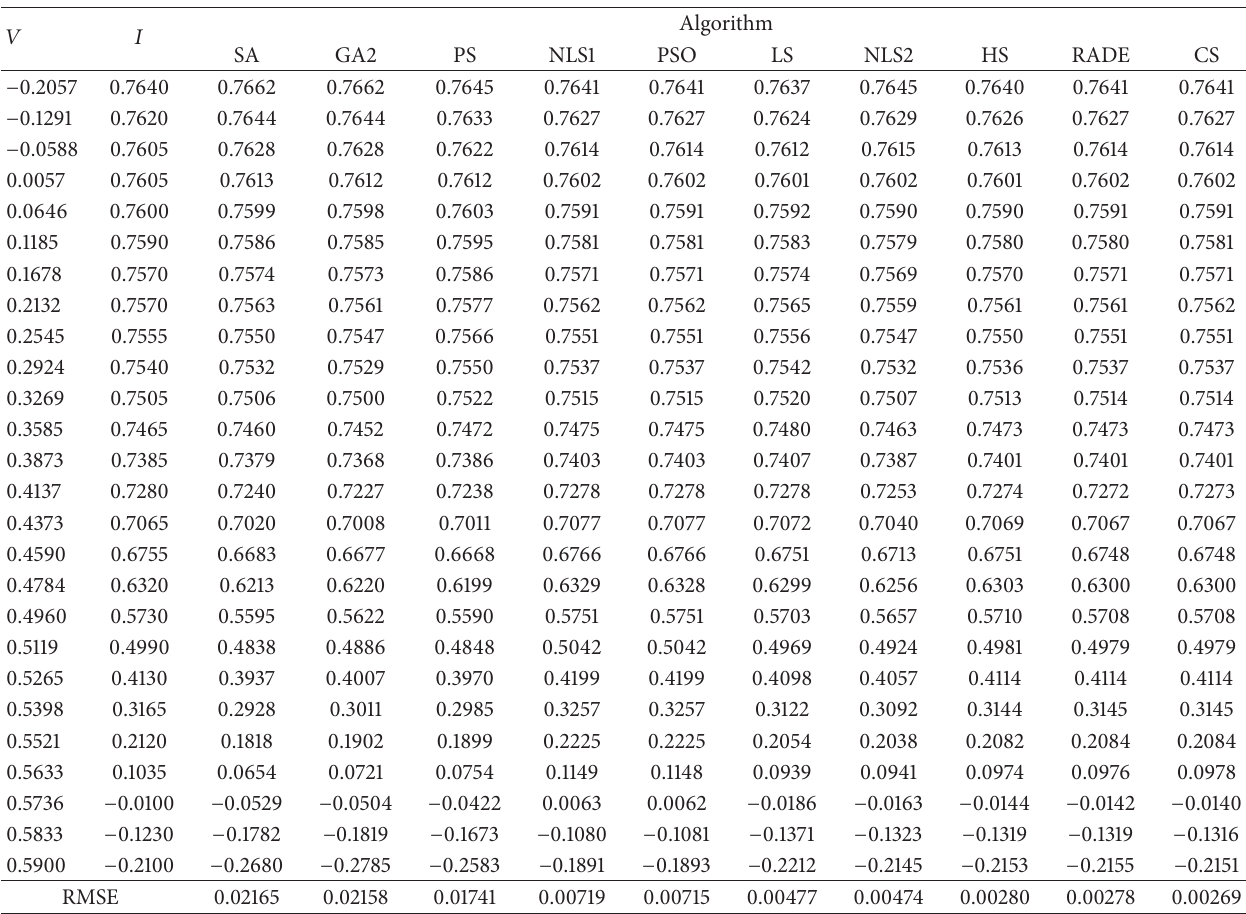
Table 1: Measured 𝐼 - 𝑉 data and computation